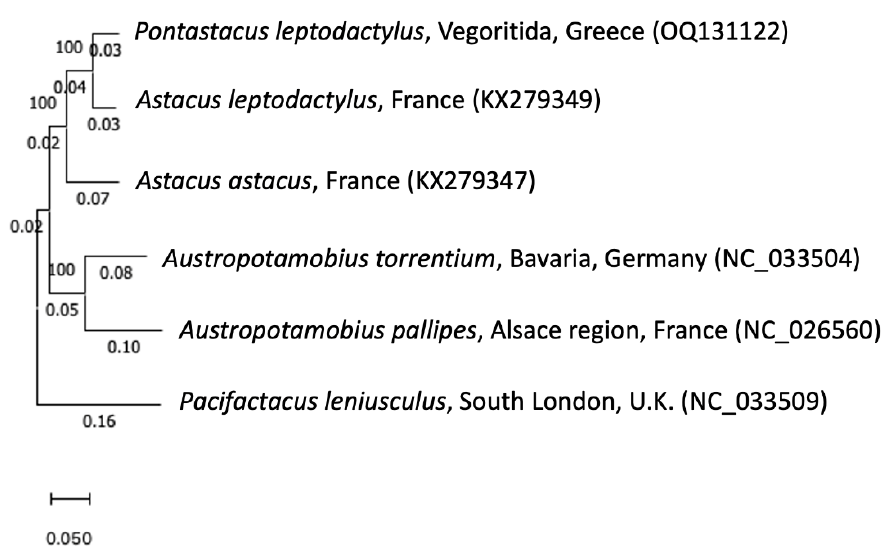
Figure 4. Maximum likelihood dendrogram depicting the phylogenetic position of Greek haplotype among the species Pontastacus leptodactylus , Astacus astacus , Austropotamobius torrentium , Austropotamobius pallipes , and Pacifastacus leniusculus .